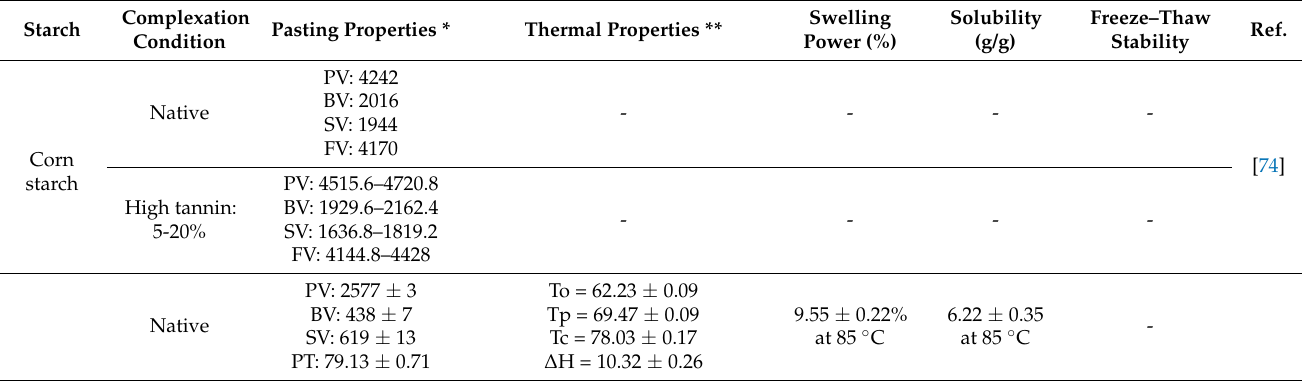
Table 3. Comparison of pasting properties, thermal properties, and functional properties of starch– polyphenol complexes and corresponding native